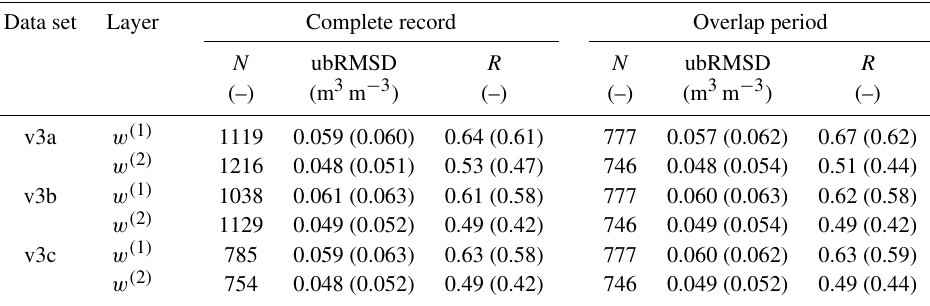
Table 2. Average validation statistics for the different soil moisture data sets (v3a, v3b, and v3c) and for the first two model layers ( w ( 1 ) and w ( 2 ) ) against in situ measurements: ubRMSD is the unbiased root mean square difference, R is the correlation, and N is the number of sites included in the sample. The first part of the table reports the averaged statistics over all available sites and the entire study period, while the second part shows the same statistics for a common sample of sites, and an overlapping study period (2011–2015) for the three data sets. The same statistics for the data sets produced using GLEAM v2 are reported between